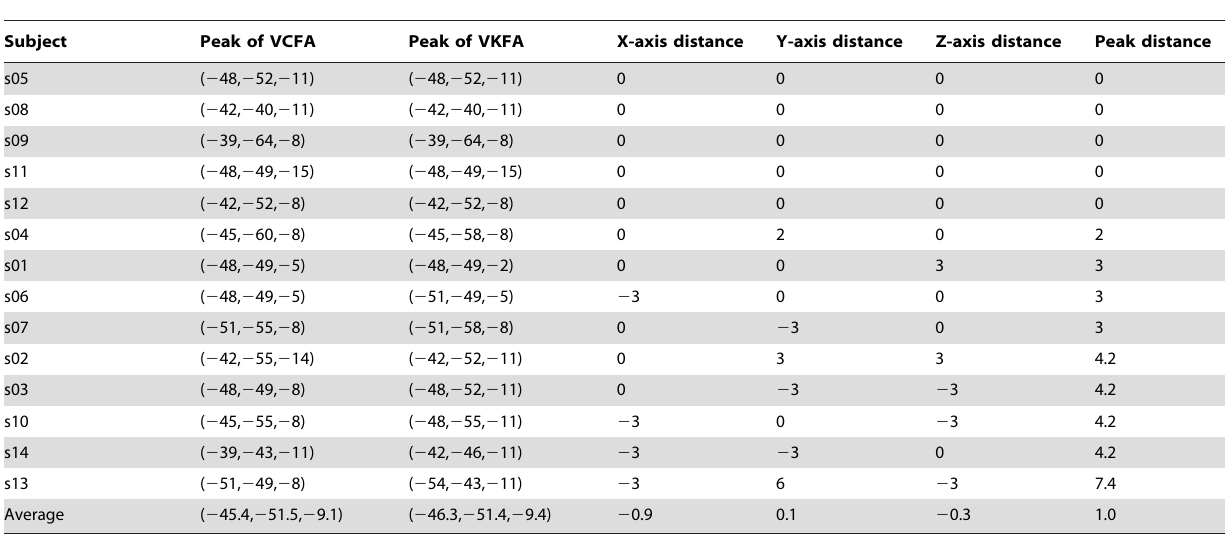
Table 1. Coordinate of VCFA and VKFA and the peak point distance (mm) between these two